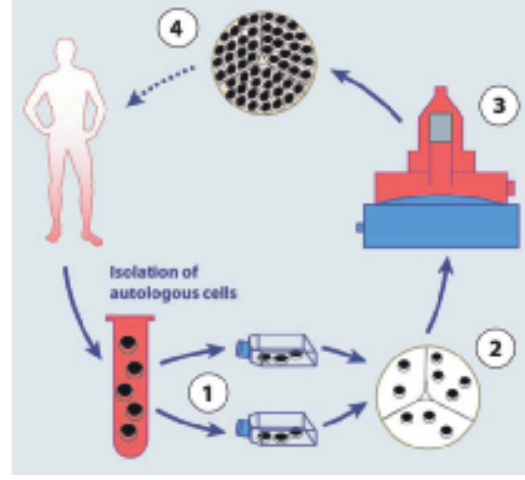
Examples of different scaffolds for heart valve tissue